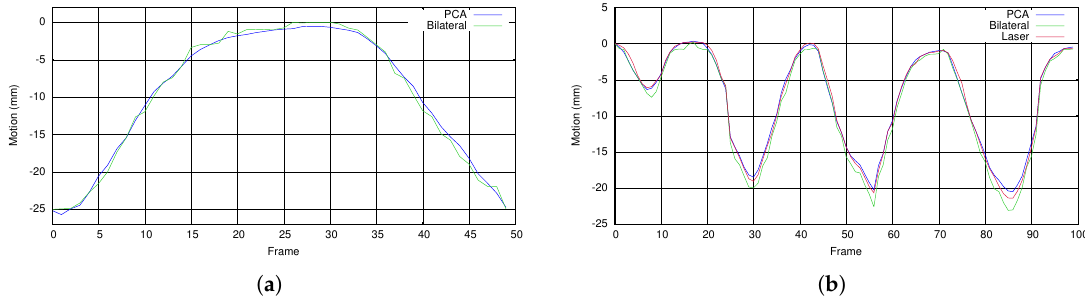
Figure 14. Comparison of the proposed PCA-based method and bilateral filtering. ( a ) A part of the motion comparison graph. The proposed PCA-based method provides a smooth curve, while bilateral filtering gives a rough curve with more temporal noise. ( b ) Comparison of the proposed PCA-based method and bilateral filtering with laser line